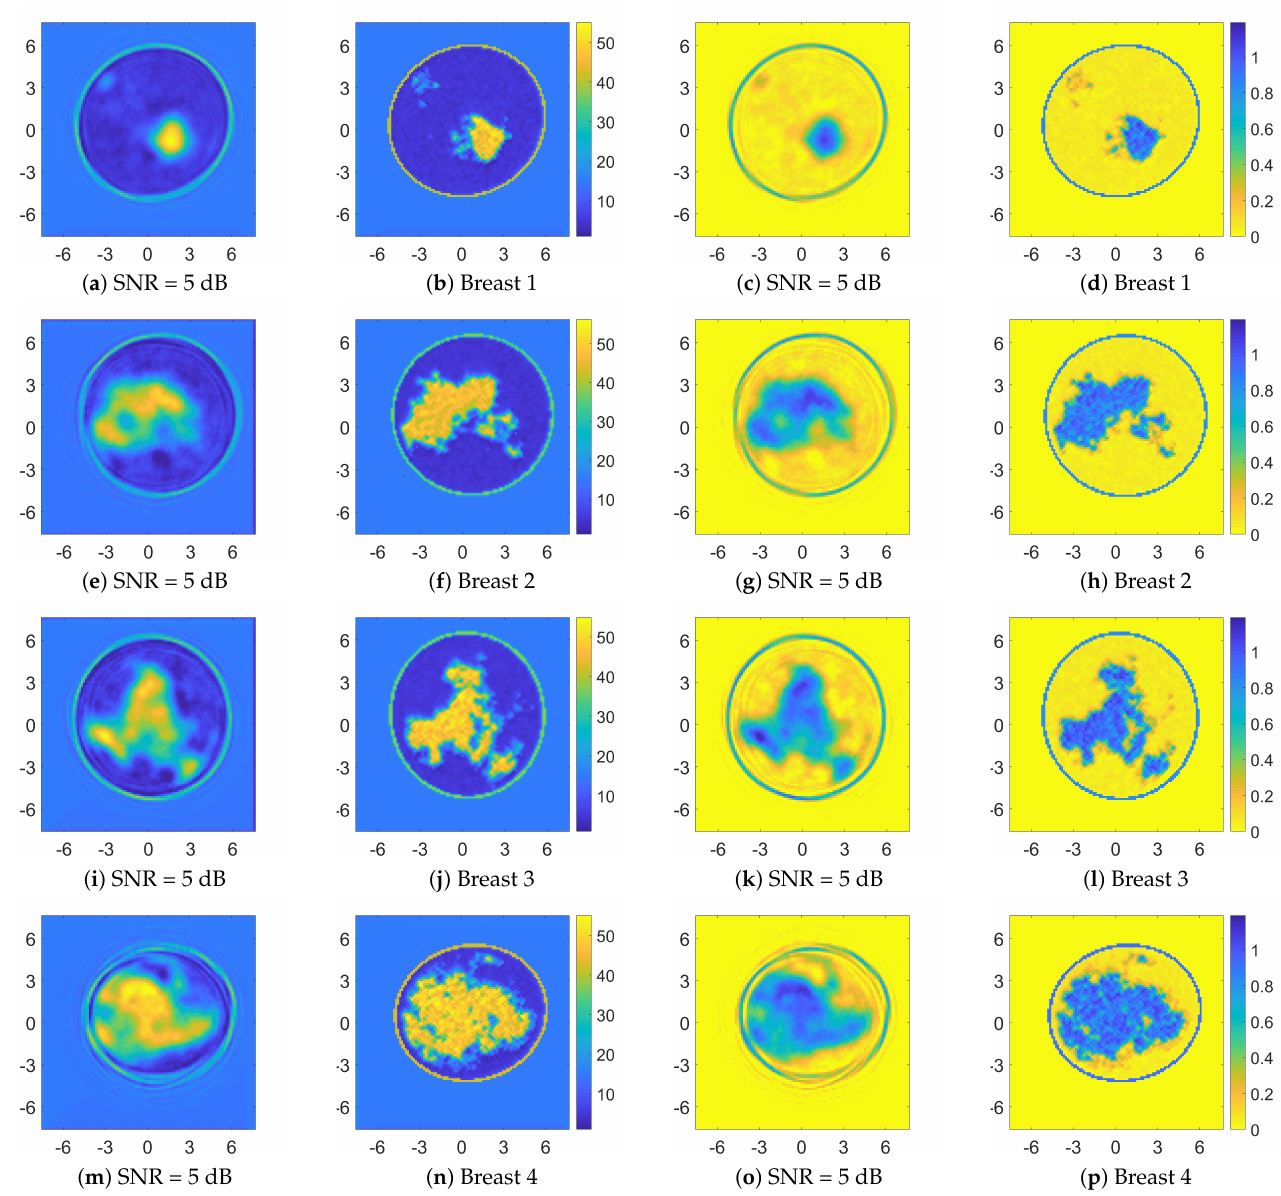
Figure 10. Performance assessment of the proposed ANN approach for an SNR = 5 dB. Retrieved per- mittivity (( a , e , i , m )—dimensionless quantity) and conductivity (( c , g , k , o )—measure unit: S/m) maps, and corresponding reference profiles ( b , f , j , n , d , h , l , p ). Both the x and y axes are in centimeter units. To further prove the robustness of the approach, its recovery performance was tested on realistic numerical breast phantoms generated from magnetic resonance images of female breasts collected by the Cross-disciplinary Electromagnetics Laboratory at the University of Wisconsin-Madison (CEM-UW) [12,75]. Thus, a few slices of these breast phantoms reported in the repository were considered, i.e., breast ID: 012204, slice 54, and breast ID: 062204, slices 47 and 71, which correspond